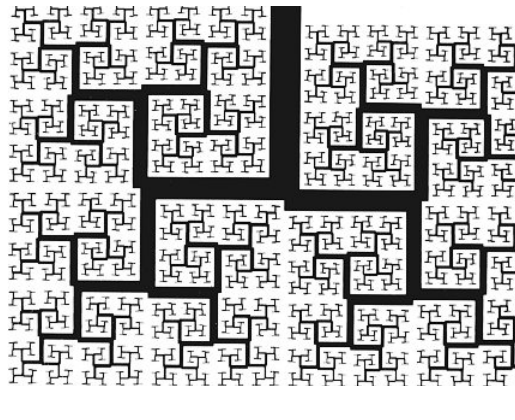
Average diameter of airways in human lung decreases with generations of airway